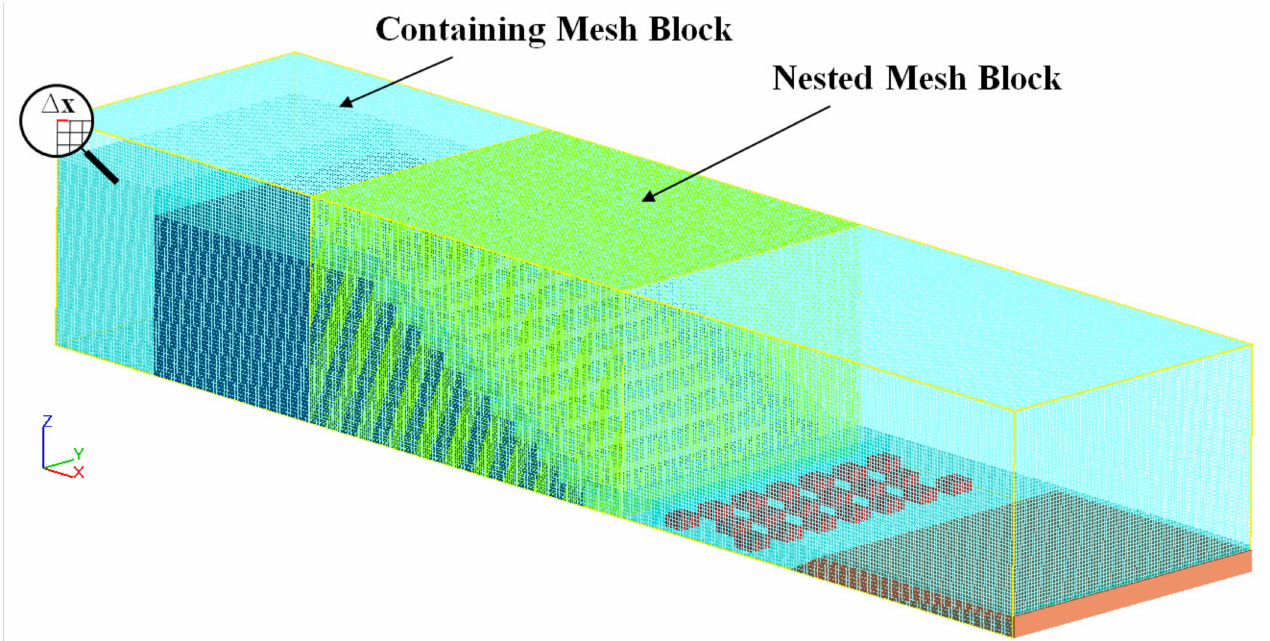
Figure 8. Meshing for FLOW-3D